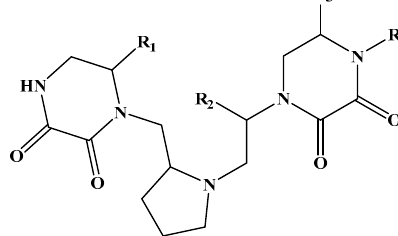
Table 1. Base structure and substituents used in the construction of the molecular library.